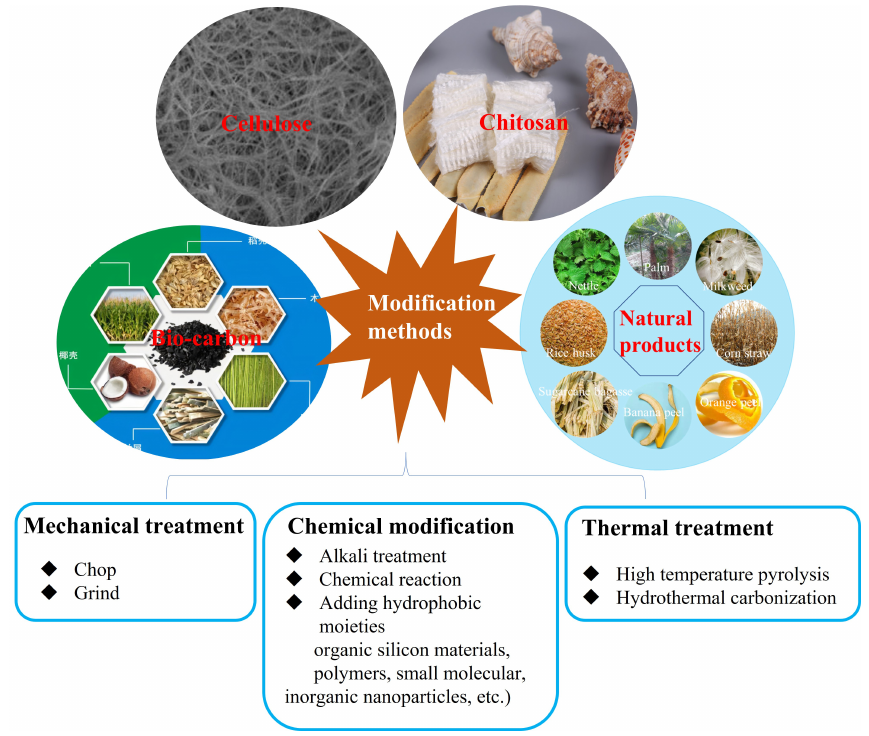
Figure 4. Modification methods for biomass